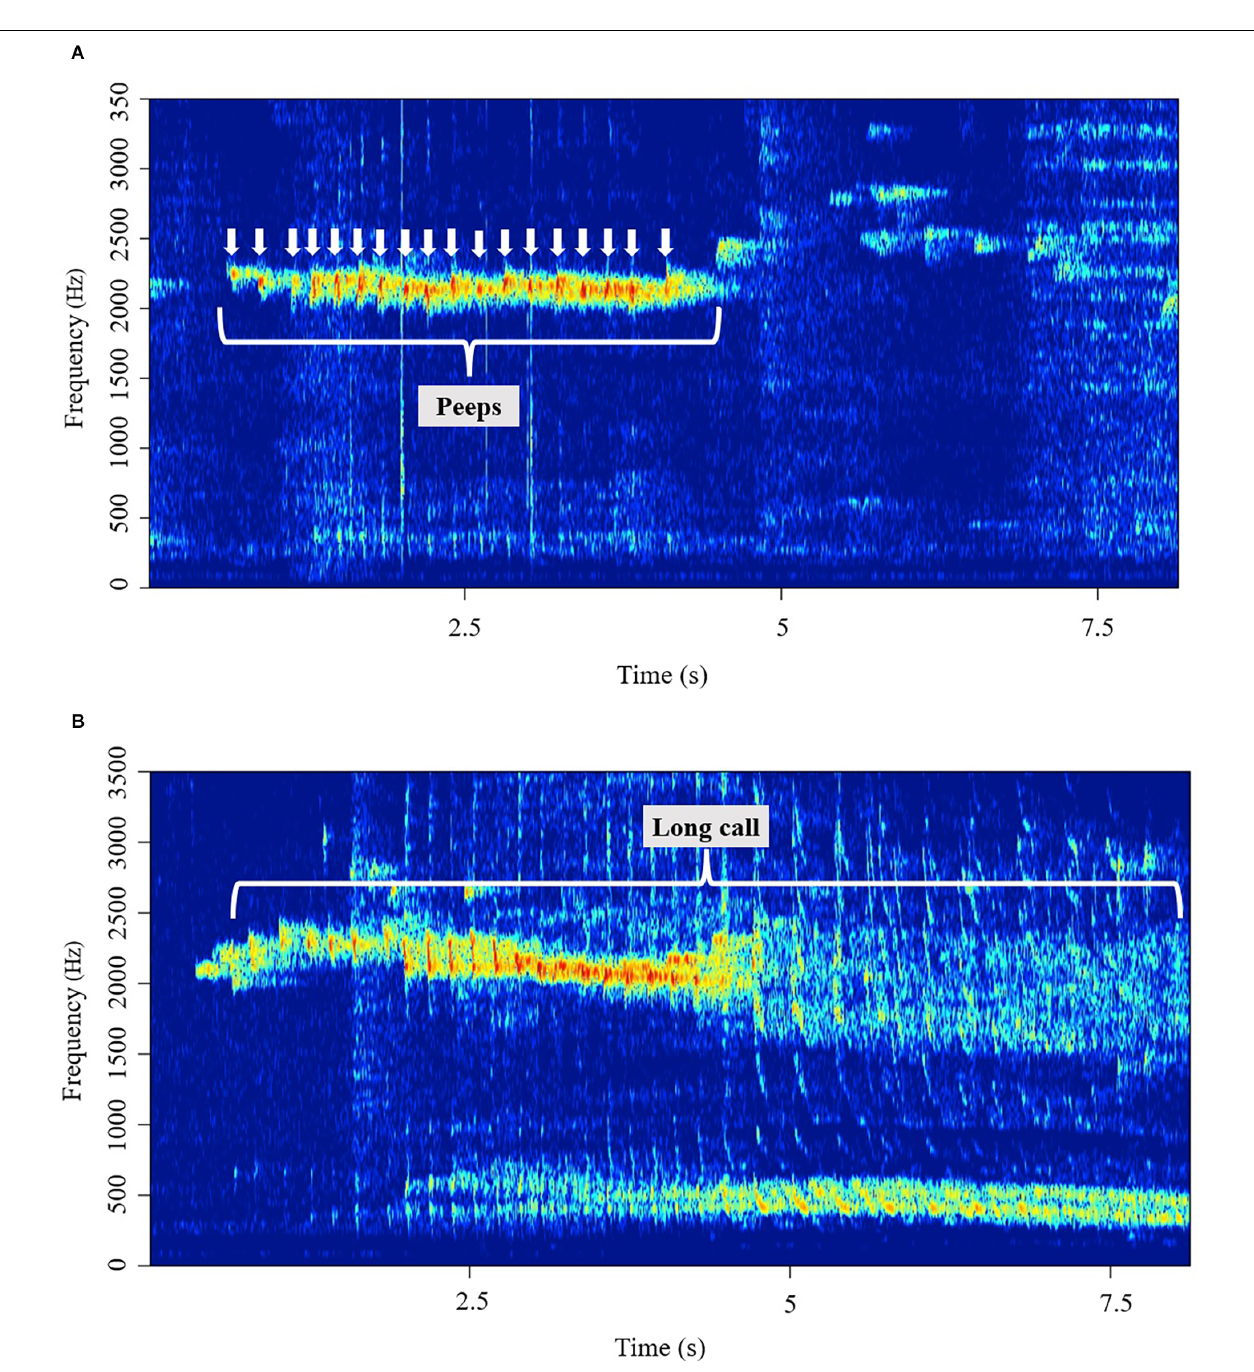
Males treated with chronic OXT and acute OXT (OXT.OXT males) vocalized fewer peeps than when they received acute SAL (OXT.SAL males). SAL.SAL males ( Figure 2D ; see Table 3 for pairwise